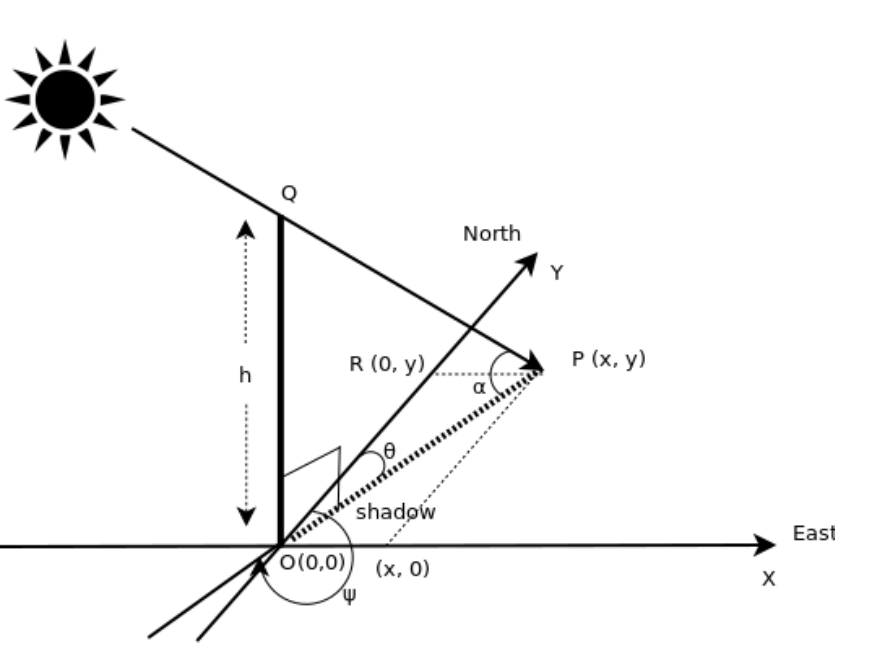
Figure 3. Shadow